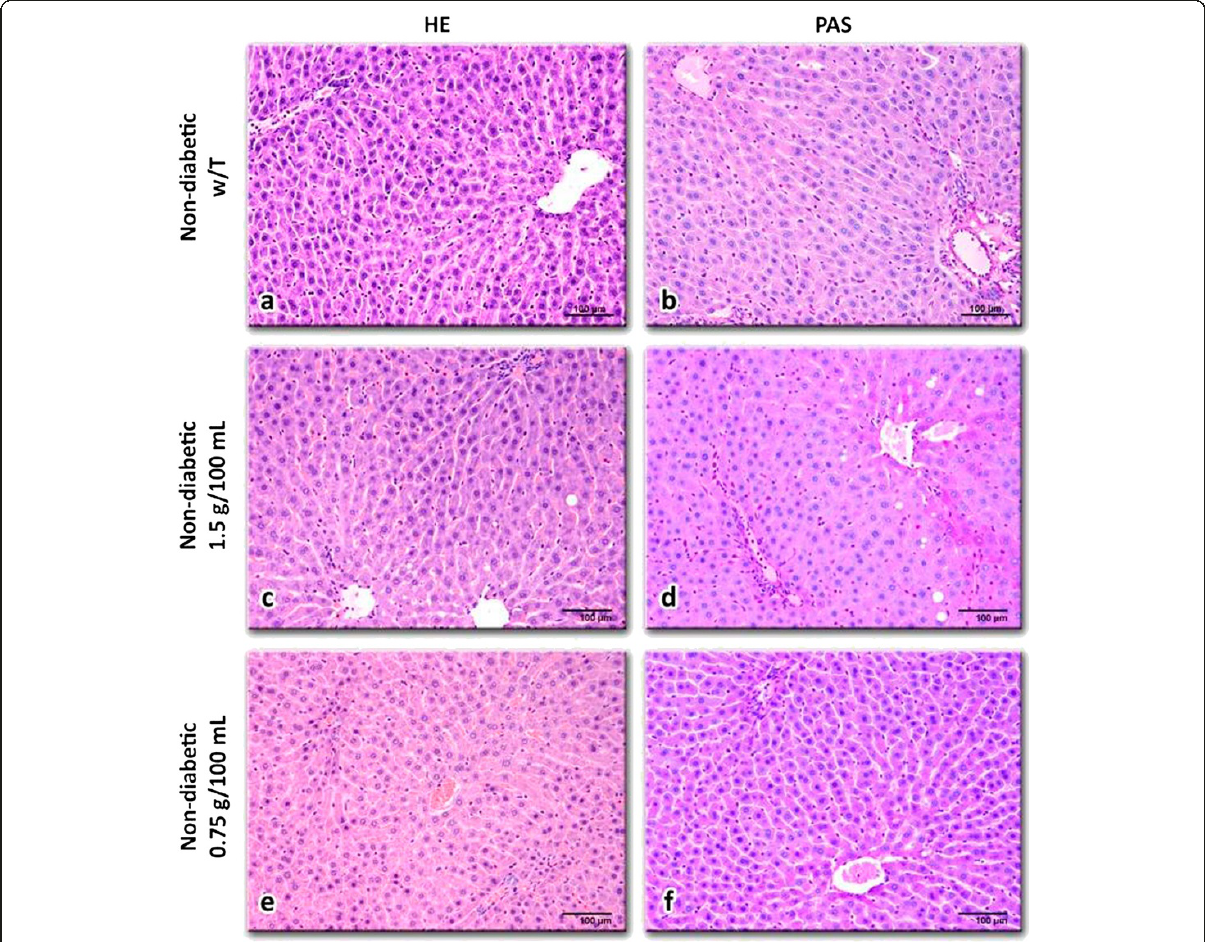
Figure 2 Liver tissue slices from non-diabetic rats without treatment (a, b) and with C. papaya aqueous extract treatments: 1.5 g/ 100 mL (c, d) or 0.75 g/100 mL (e, f). All liver sections showed normal structure; however, rat livers treated with 1.5 g/100 mL of C. papaya extract exhibited slight univesicular steatosis near the central veins. Glycogen content in all cases was insignificant. Hematoxylin-eosin ( a, c, e ) and PAS ( b, d, f ) staining,